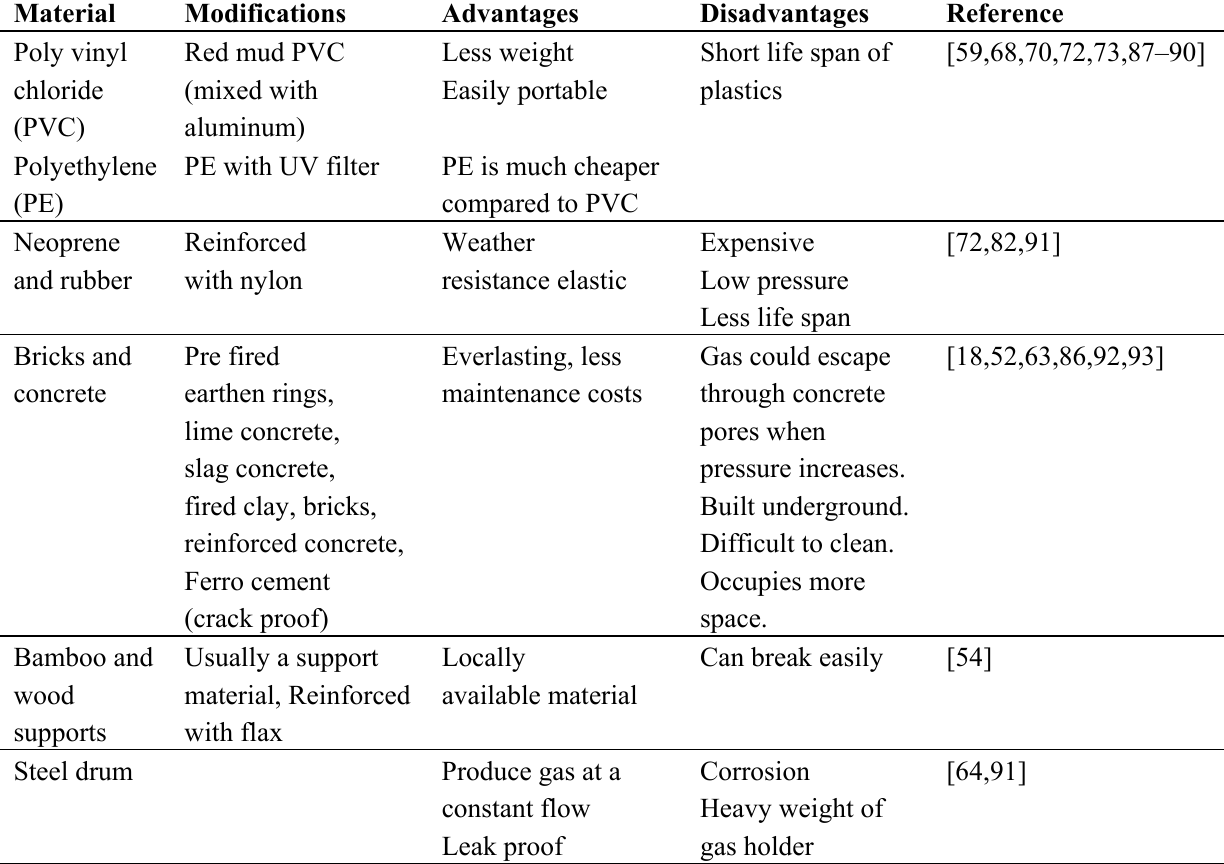
Table 1. Different materials used for construction of digesters with their advantages and